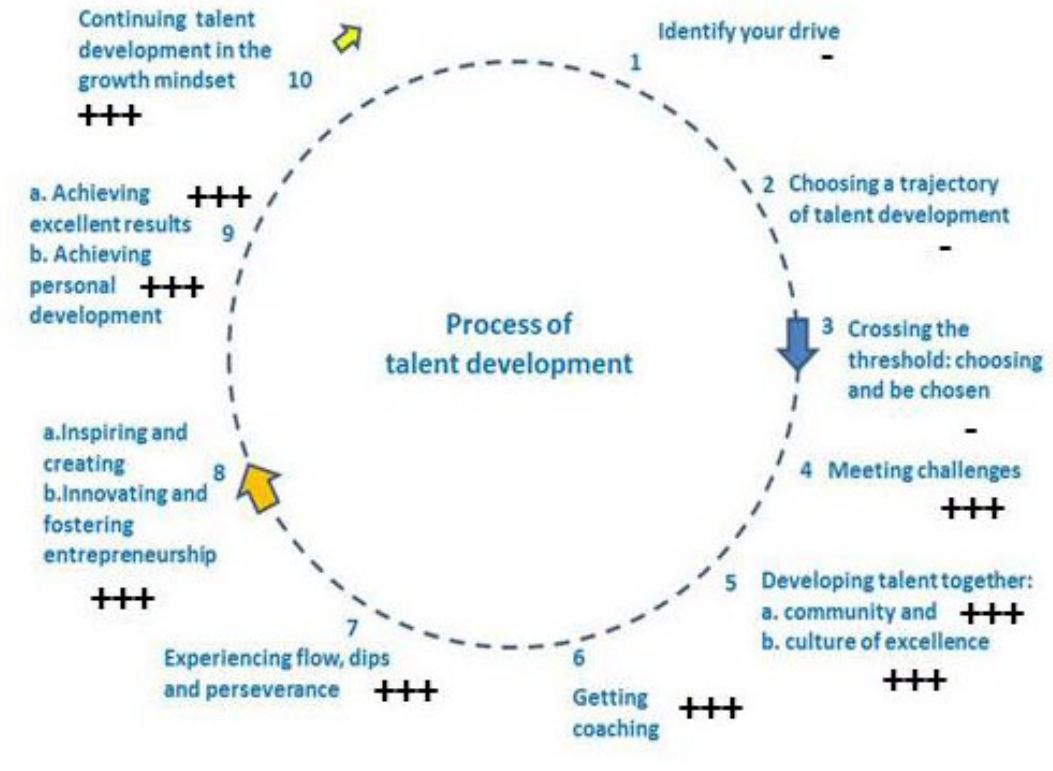
Figure 3: Circle of Talent Development in relation with the good practice